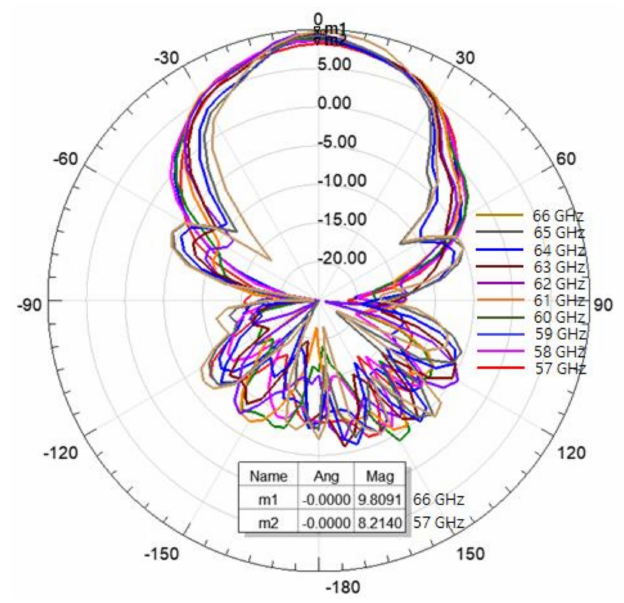
Figure 16. Beam pattern results for the 2 × 2 array antenna.